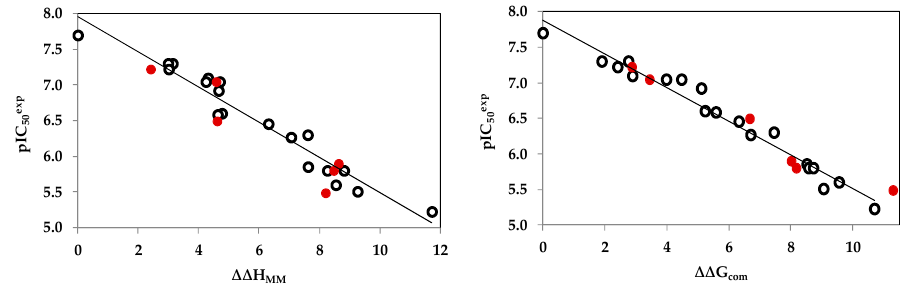
Figure 2. (Left) plot of correlation equation between pIC 50 exp and relative enthalpic contribution to the GFE (Equation (6)) ∆∆ H MM [kcal · mol − 1 ]. (Right) similar plot for relative complexation Gibbs free energies of the InhA-BHMBx complex formation ∆∆ G com [kcal · mol − 1 ] of the training set [23]. The validation set data points are shown in red color.